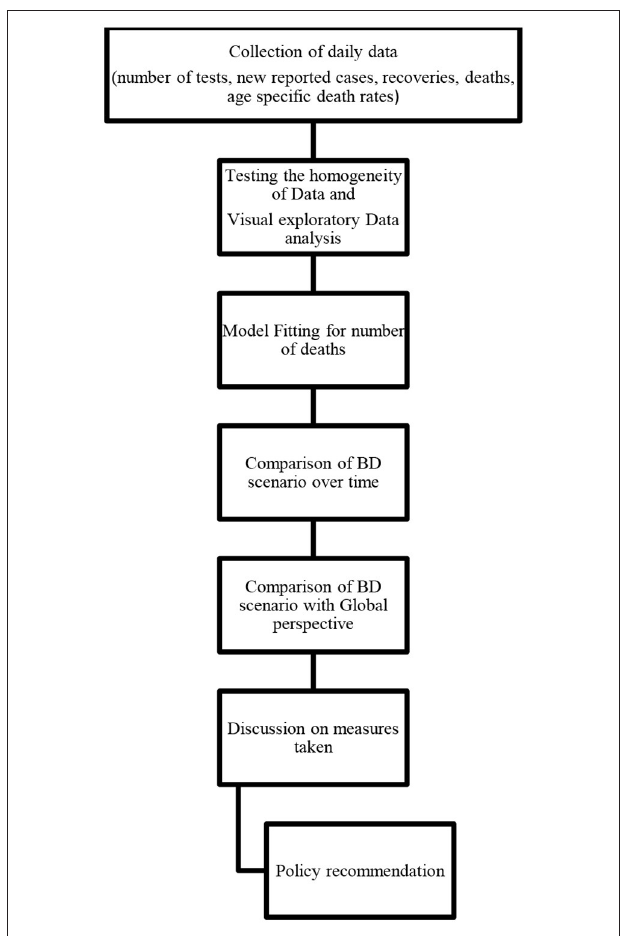
FIGURE 1 | Systematic